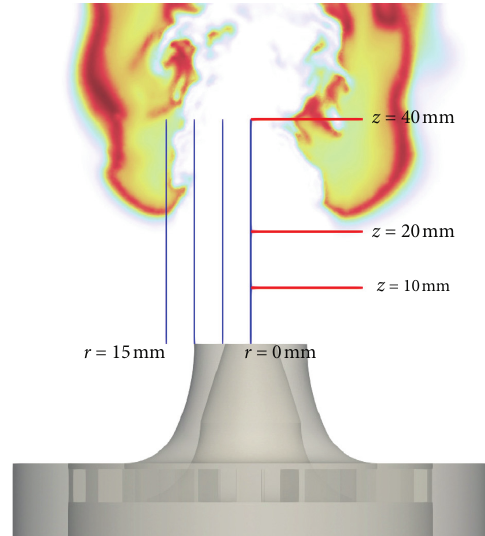
Figure 5: Positions of the profiles of the experimental database. Red lines: radial profiles at Z � 10, 20, and 40mm. Blue lines: axial profiles at r � 0, 5, 10, and 15